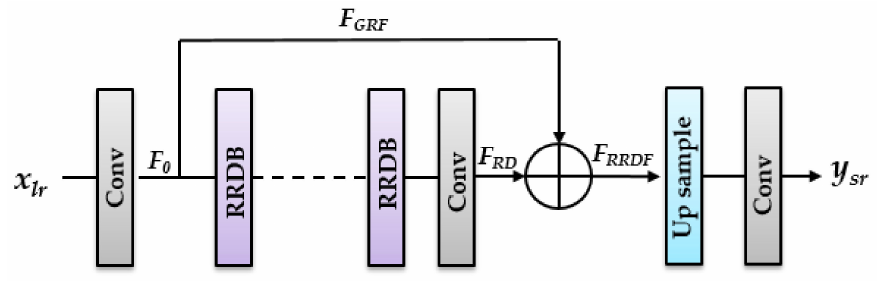
Figure 3. Structure of proposed